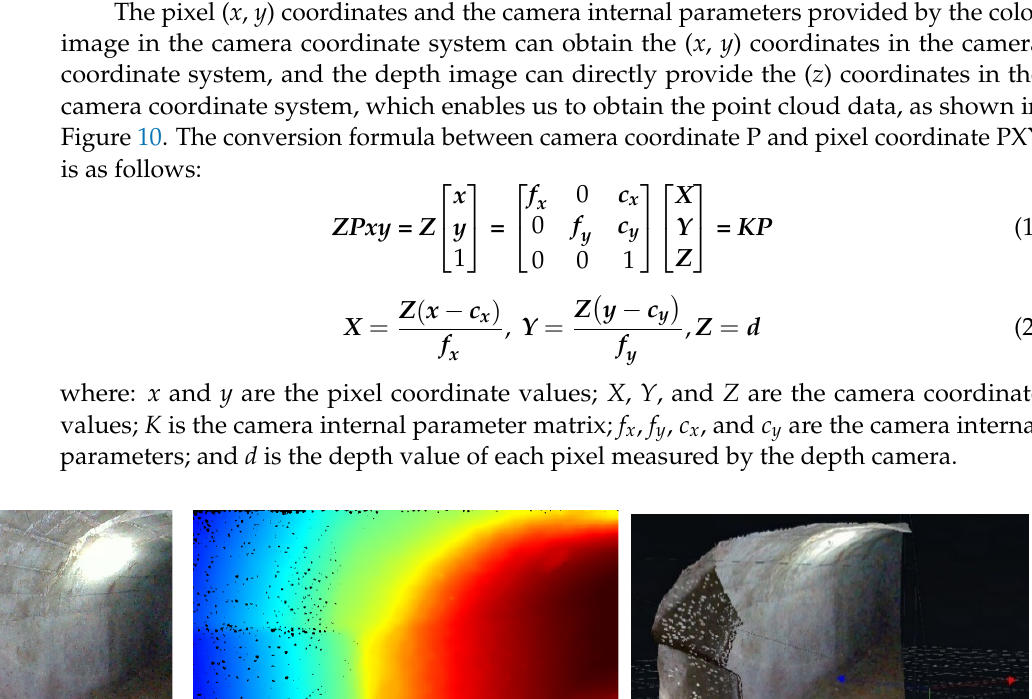
Figure 9. Before and after 3D laser point cloud registration. ( a ) Point cloud before registration; ( b ) Point cloud after registration.